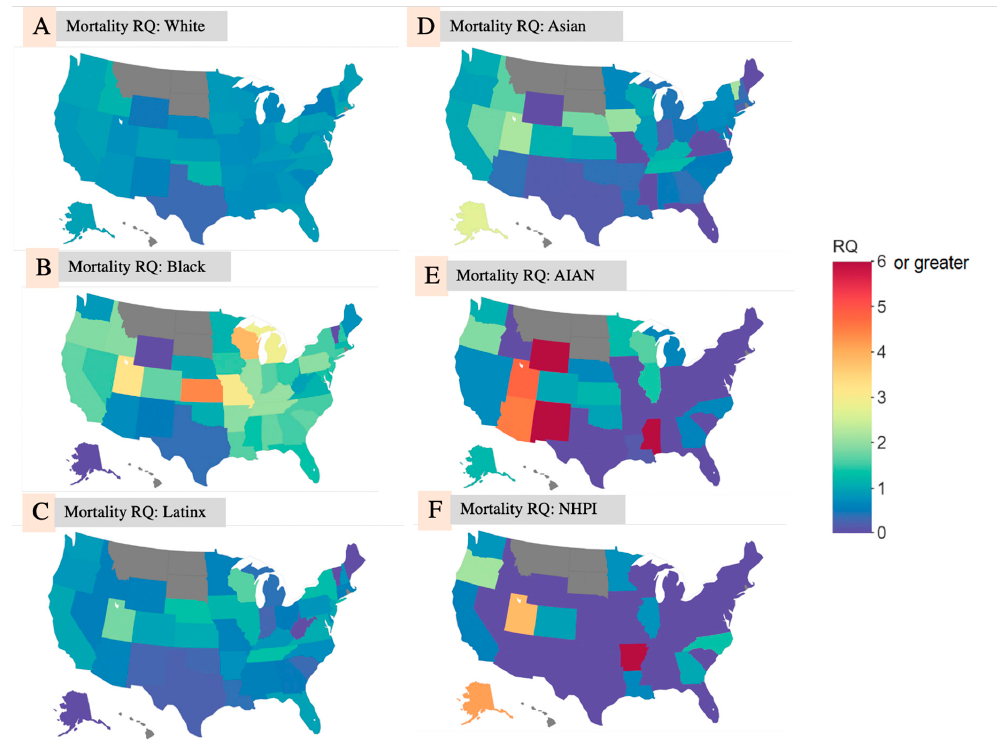
Figure 2. Choropleth Maps of COVID-19 Death RQ by State among ( A ): White people; ( B ): Black people; ( C ): Latinx people; ( D ): Asian people; ( E ): AIAN; ( F ): NHPI.